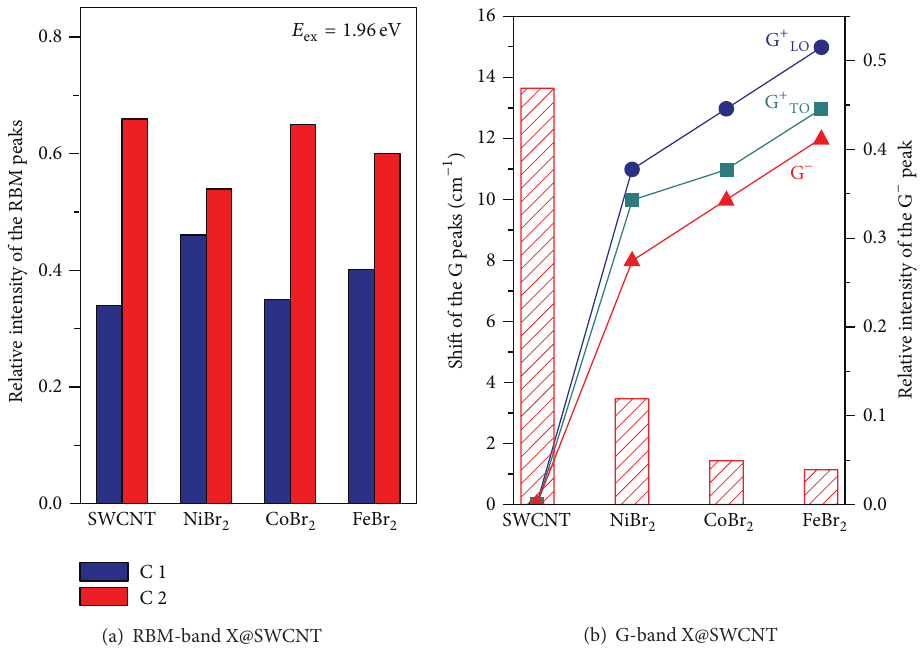
Figure 5: The relative intensity of the RBM components (C 1 and C 2) (a), the shift of the G-band components (G − , G + and the relative intensity of the G − -component (b) in the Raman spectra of the pristine SWCNTs, NiBr 2 @SWCNT, CoBr 2 @SWCNT, and FeBr 2 @SWCNT samples, acquired at a laser energy of 1.96